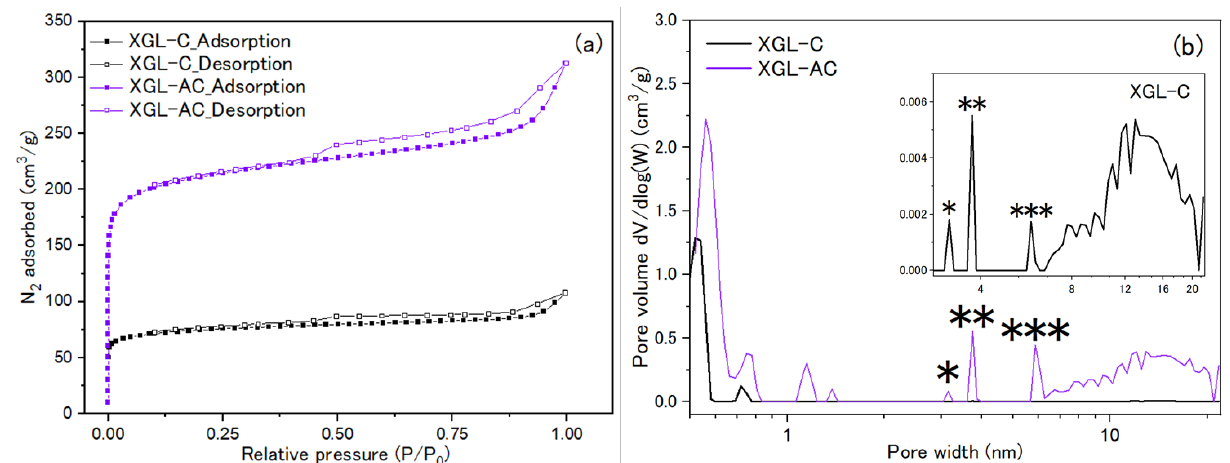
Figure 2. ( a ) Nitrogen adsorption isotherm of XGL-C and XGL-AC and ( b ) pore-size distribution calculated from DFT method. The asterisks are the matching peaks in the inset graph.